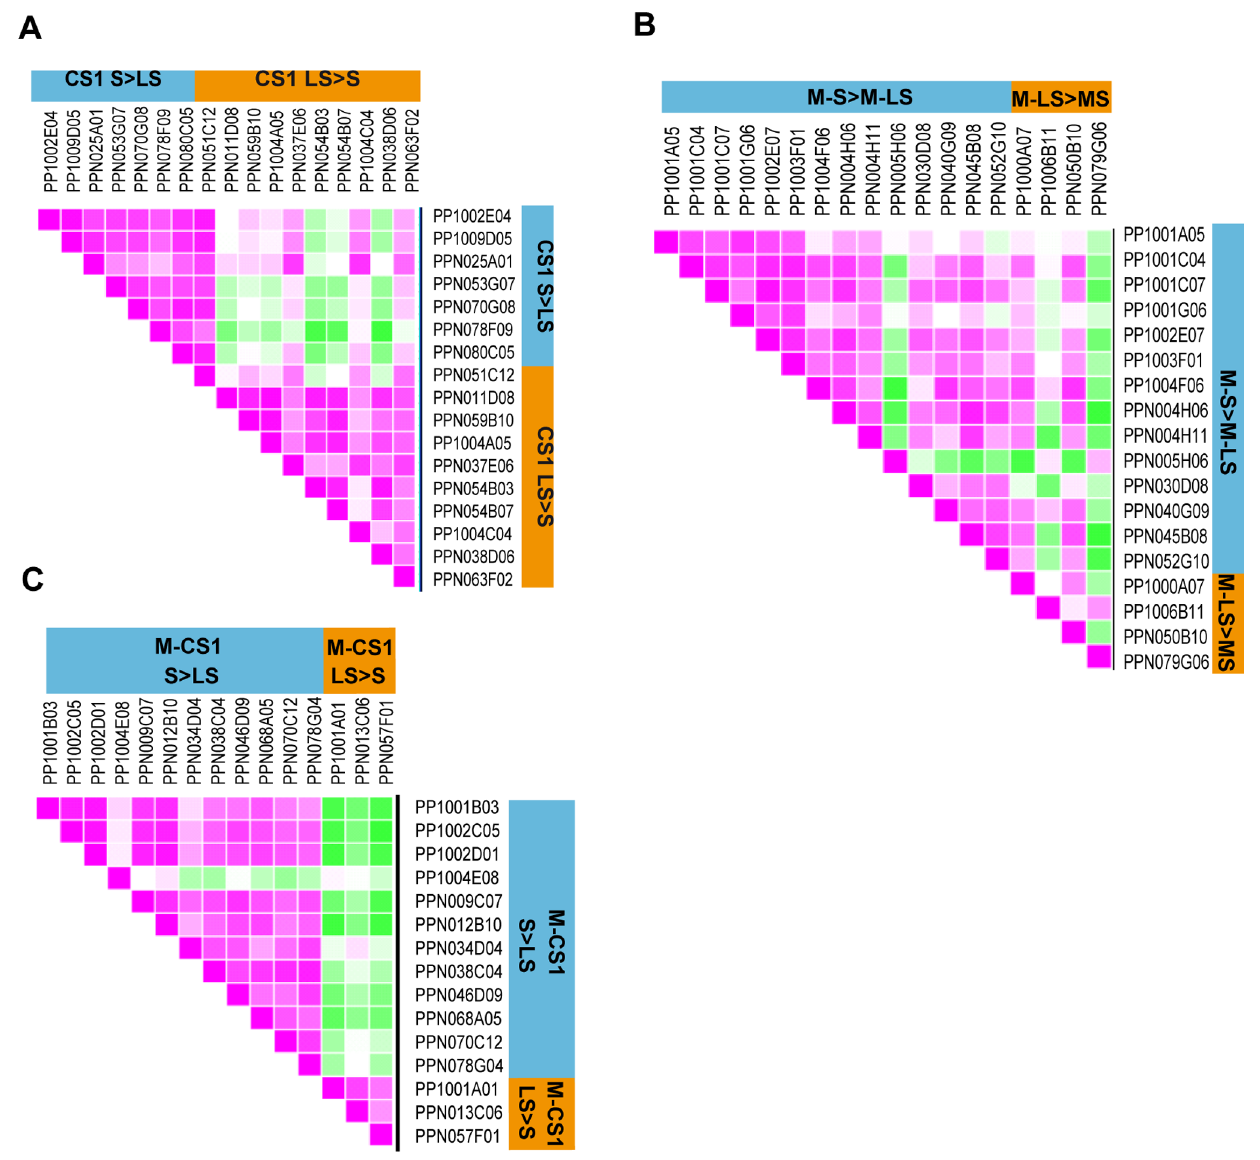
Figure 5. Degree of association between the genes validated by Fluidigm in a pre-defined expression pattern from the pools in the microarray and in individual Pop-DG siblings. A) The differentially expressed genes at 1 week of cold storage; B) The differentially expressed genes in the M stage and at 1 week of cold storage; C) The differentially expressed genes in the M stage. The Heatmap values correspond to the Pearson correlation coefficients between pairs of genes. For each gene in a gene set, the expression profile from the microarray results was defined and the Pearson correlation coefficients were calculated for pairs of genes in the individual sibling lines.